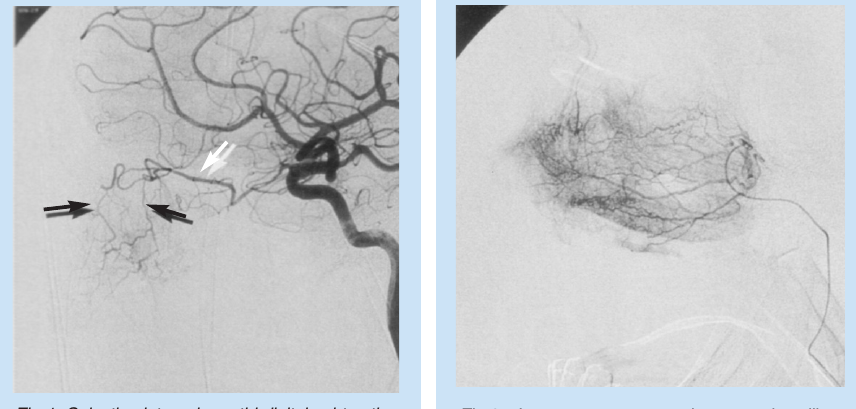
Fig 1. Selective internal carotid digital subtraction arteriogram showing supply to the superior nasal cavity via the ethmoidal branches (black arrows) of the ophthalmic artery (white arrow).